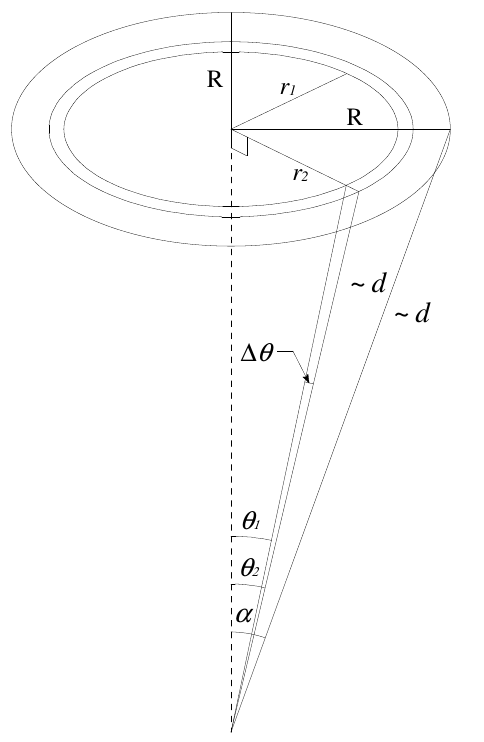
Fig. A2. Geometry used to calculate the radiant power intercepting a flat plane at some distance d from a scattering particle.